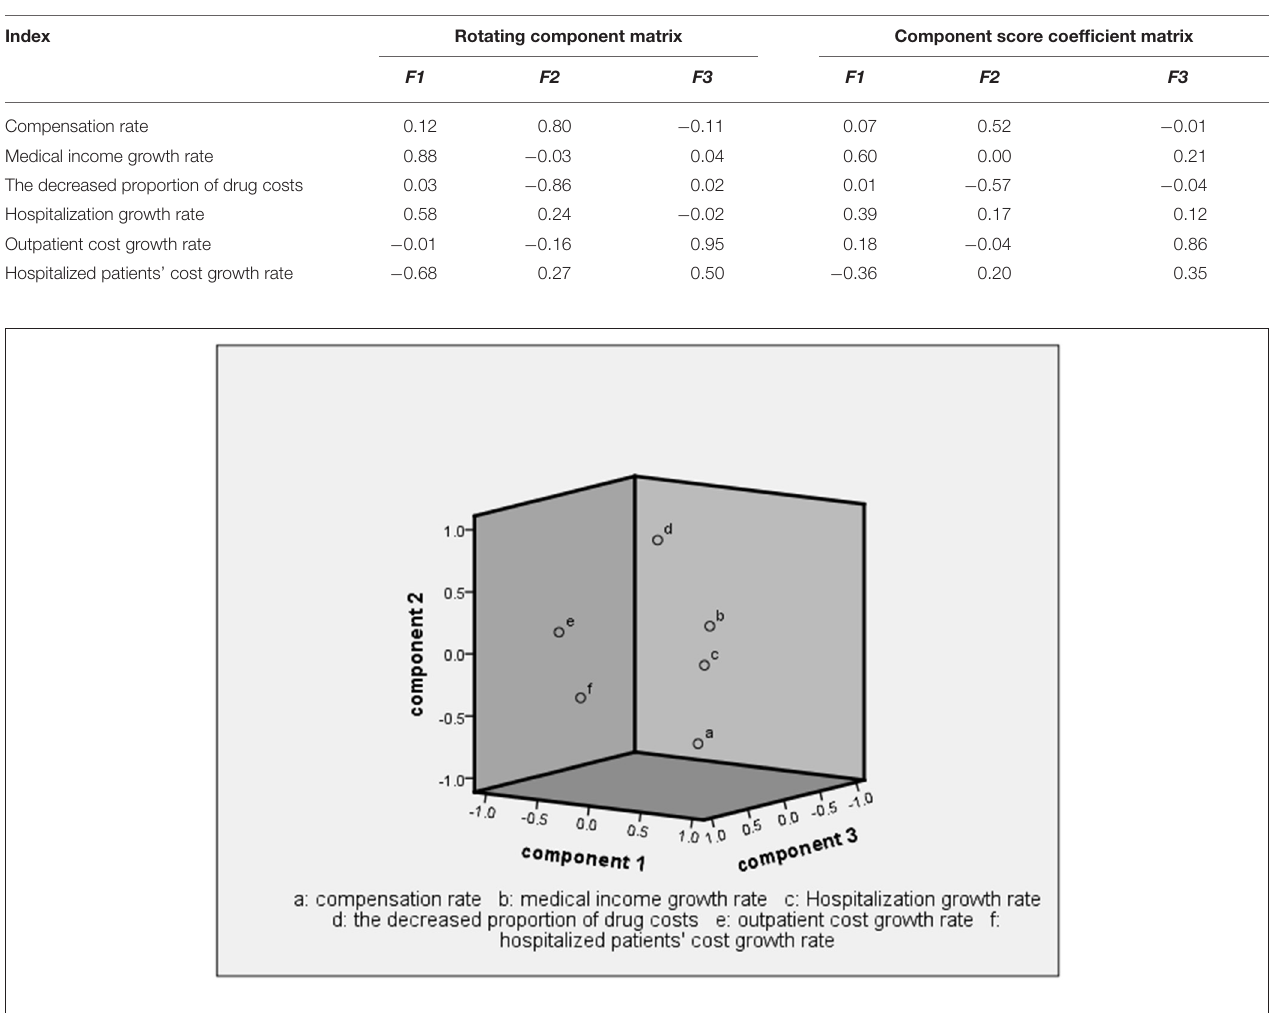
TABLE 4 | Rotating component matrix and coefficient matrix after conversion.